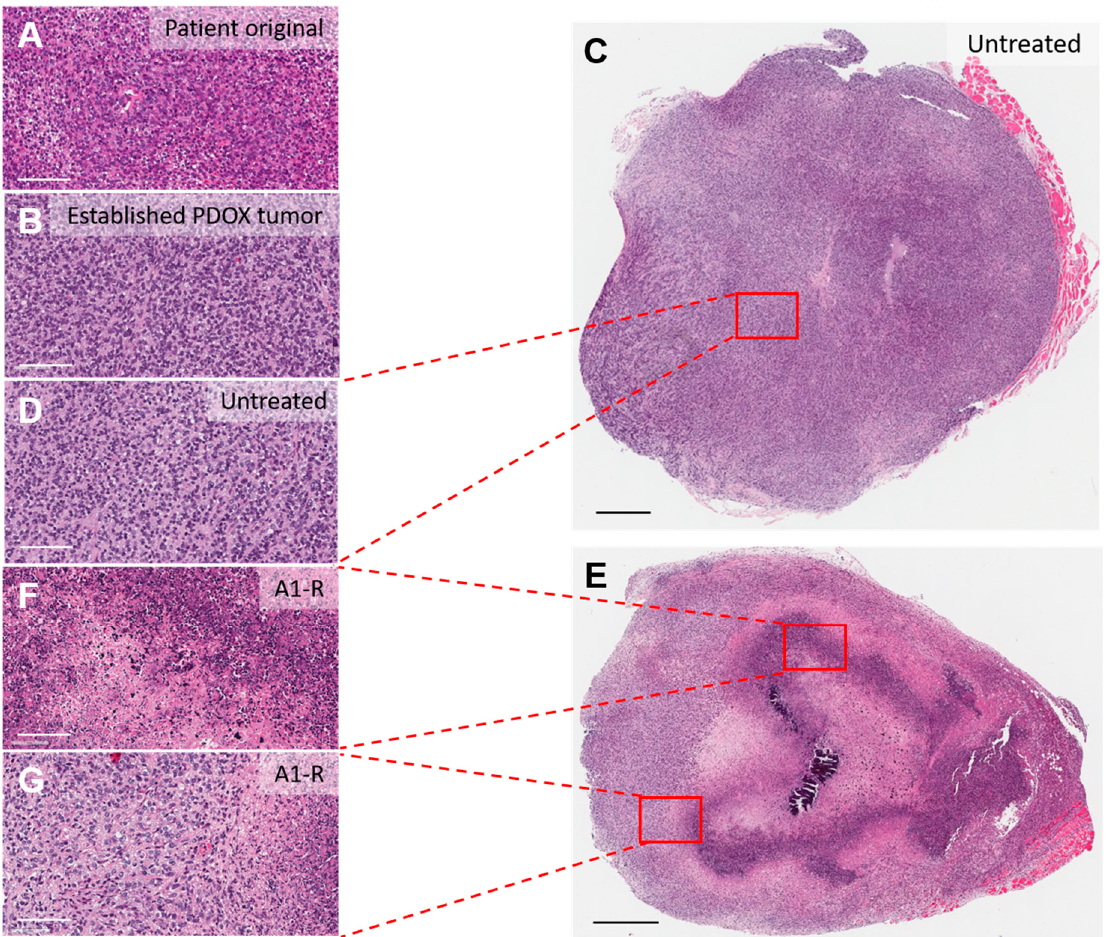
Figure 4. Histological findings in untreated tumors and tumors treated with S. typhimurium A1-R in the Ewing’s sarcoma PDOX model ( H and E staining). ( A ) Ewing's sarcoma from the original patient tumor. ( B ) High-magnification image of an established tumor in a Ewing's sarcoma PDOX model. ( C ) Whole tumor image of untreated control tumor in a Ewing's sarcoma PDOX model. ( D ) High-magnification image of ( C ). ( E ) Whole tumor image of a S. typhimurium A1-R-treated tumor in a Ewing's sarcoma PDOX model. ( F , G ) High-magnification images of (E). Scale bars in (A,B,D,F,G): 100 μ m; scale bars in ( C , E ): 500 μ m.